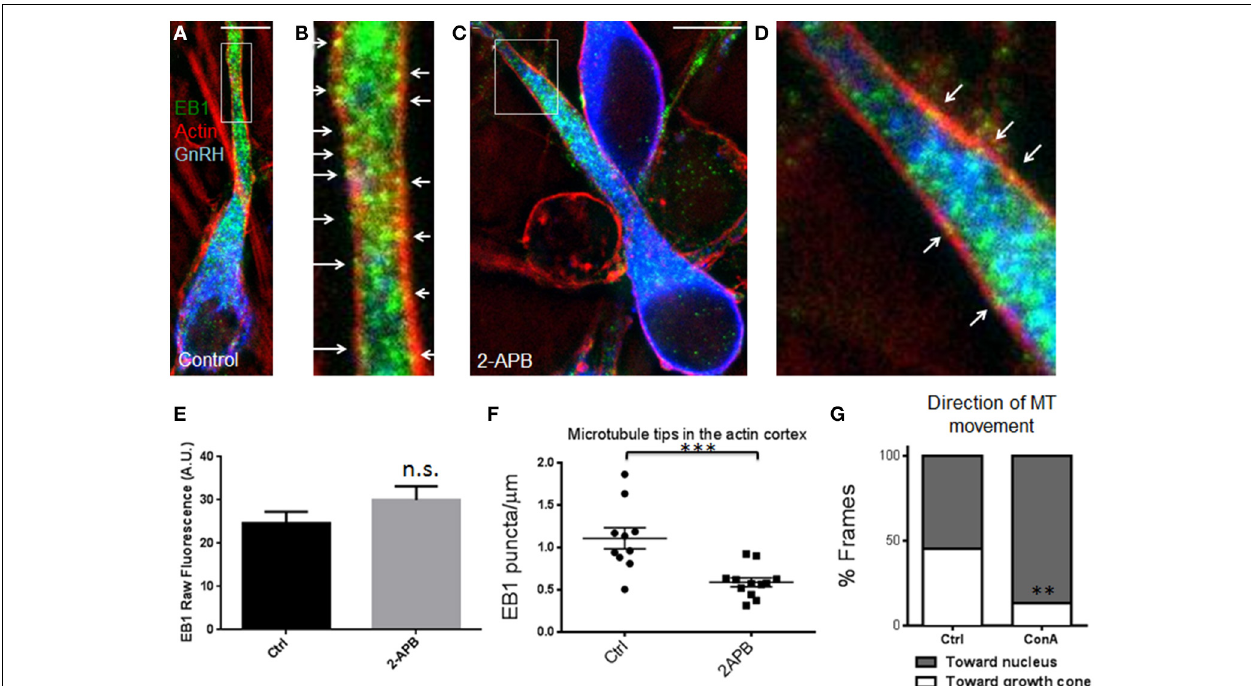
FIGURE 4 | Microtubule + TIPs lose association with cortical actin after blocking calcium release. (A) Triple-staining against EB1 (green), F-actin (red), and GnRH (blue) in a control-treated cell with EB1 and F-actin imaged with STED microscopy. (B) Zoomed image of the box in (A) . Arrows indicate examples of super-resolution co-localization, showing several EB1 puncta associated with the actin cortex in the leading process. (C,D) Low (C) and high magnification ( D , of region boxed in C ) of triple-stained neurons treated with 2-APB. Blocking calcium release reduces the number of EB1 puncta associated with the actin cortex (arrows, D ). Scale bars, 5 µ m. (E) No